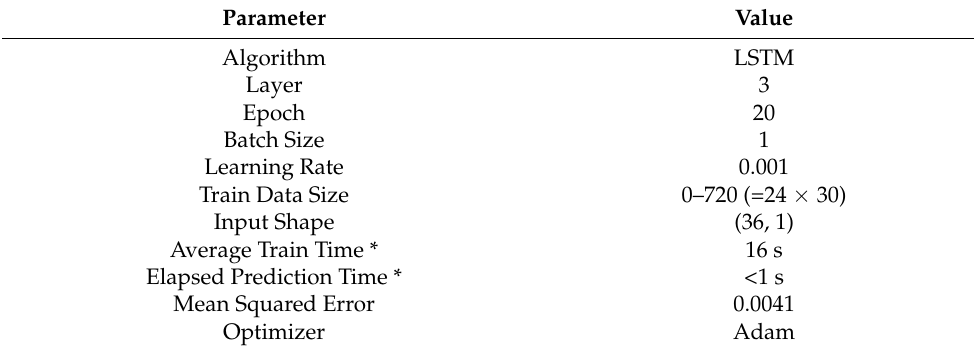
Table 2. Base load prediction model.